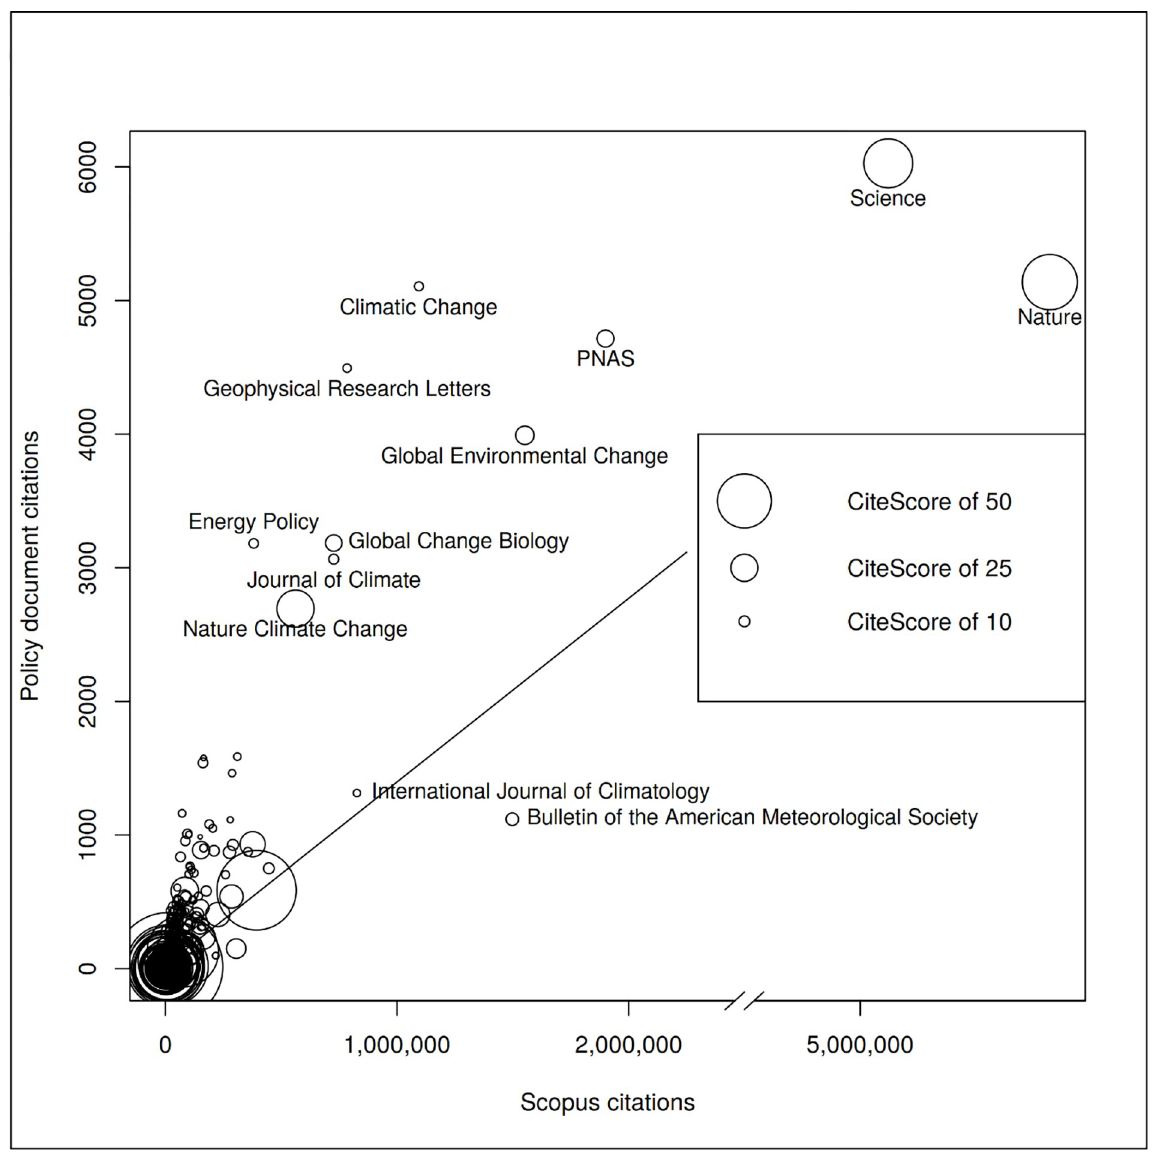
Fig 9. Correlation between the journal-based number of climate change policy document citations and Scopus citations. The size of the circles reflects the CiteScore of the journals (Spearman rank correlation = 0.81; an interactive version can be viewed at: https://s.gwdg.de/